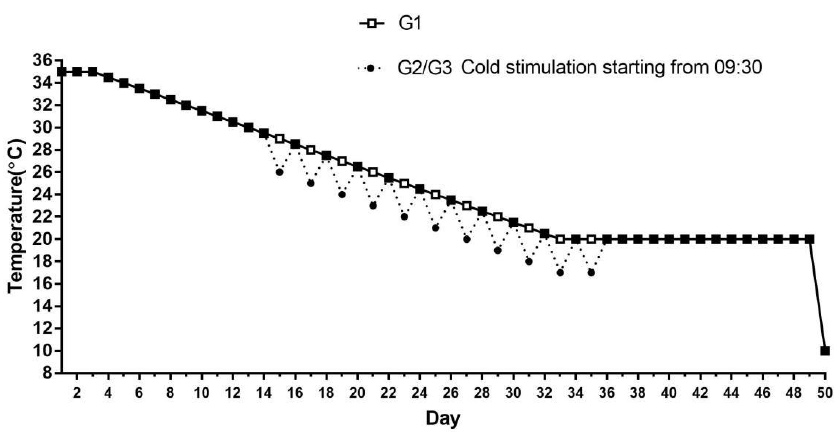
Figure 1. The specific experimental temperature